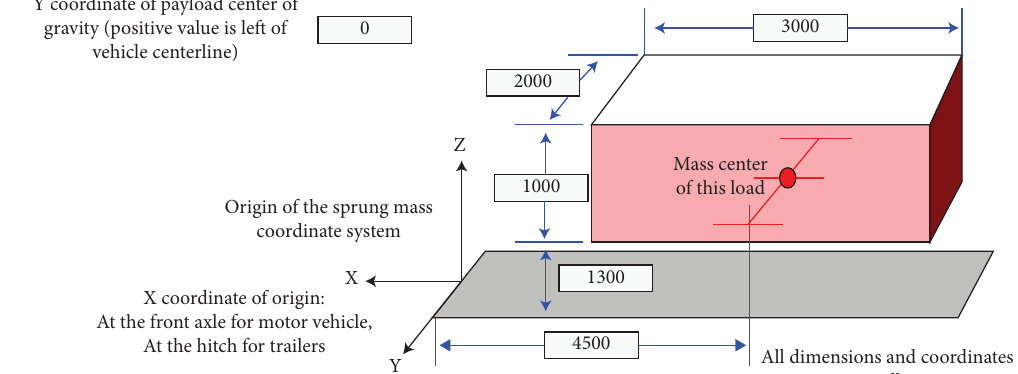
Figure 8: Two-axle truck cargo